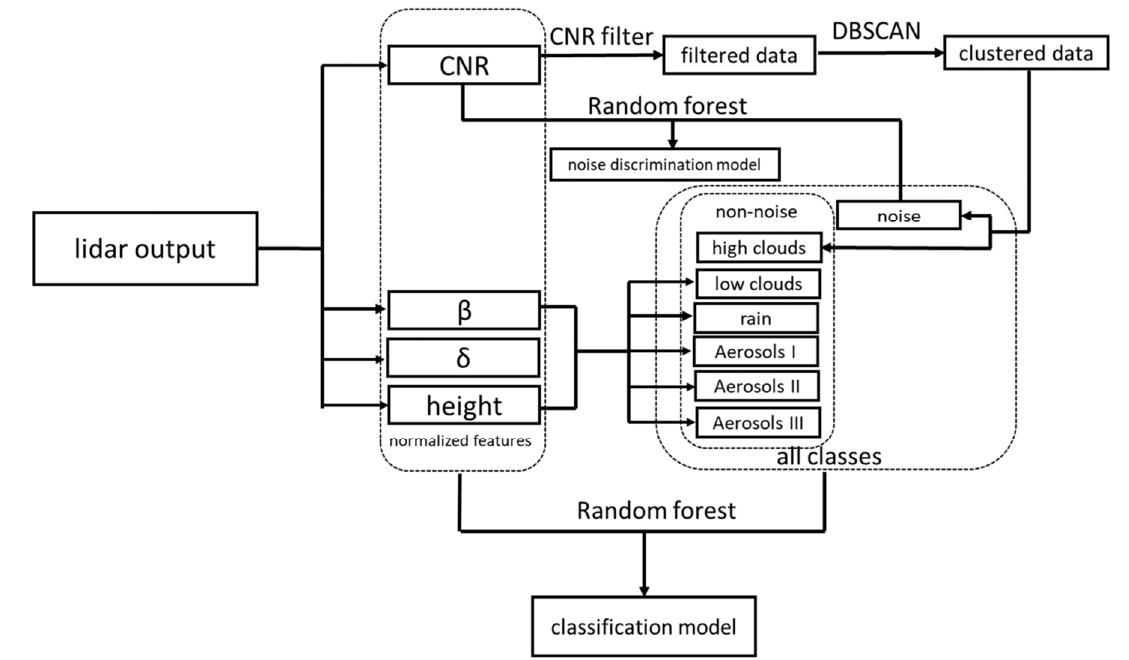
Figure 3. Overview of the process of the method. The text above the arrows is the methods used for that procedure. The noise discrimination model and the classification model are the two trained models.